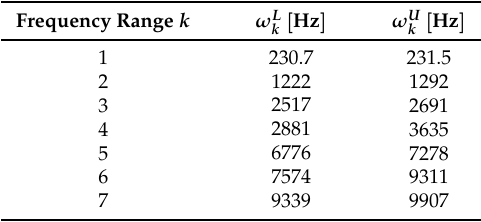
Table 3. Frequency bands to be